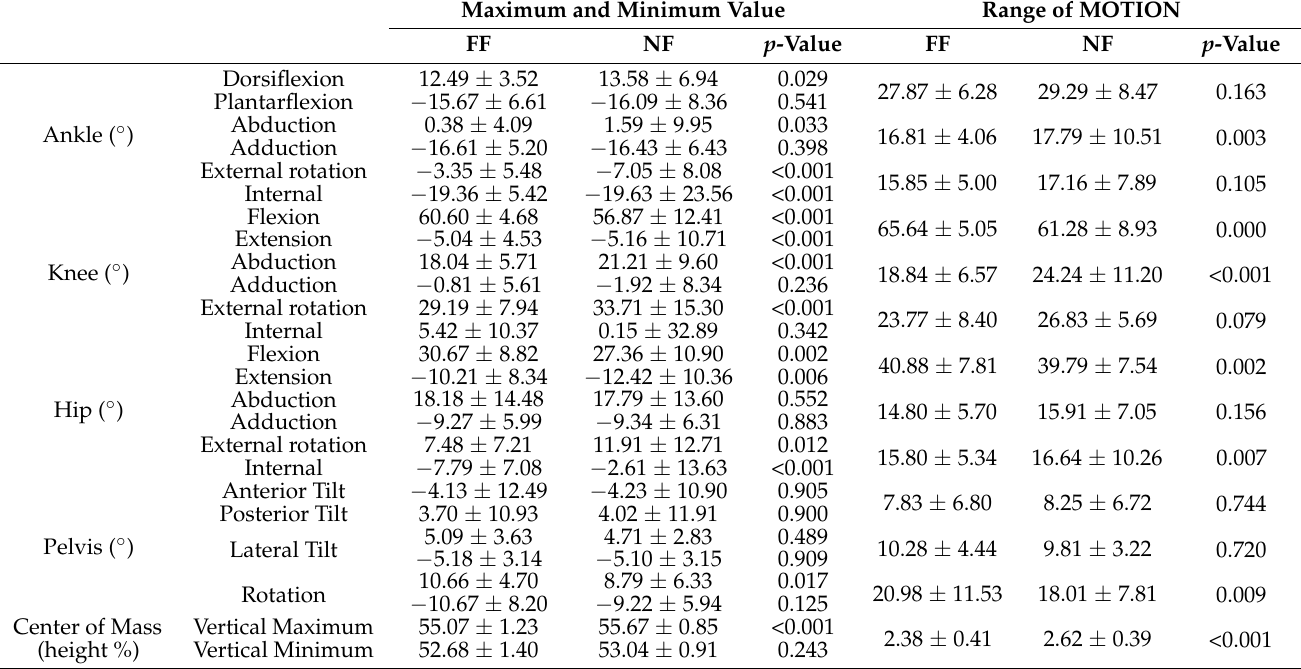
Table 2. Groups kinematics